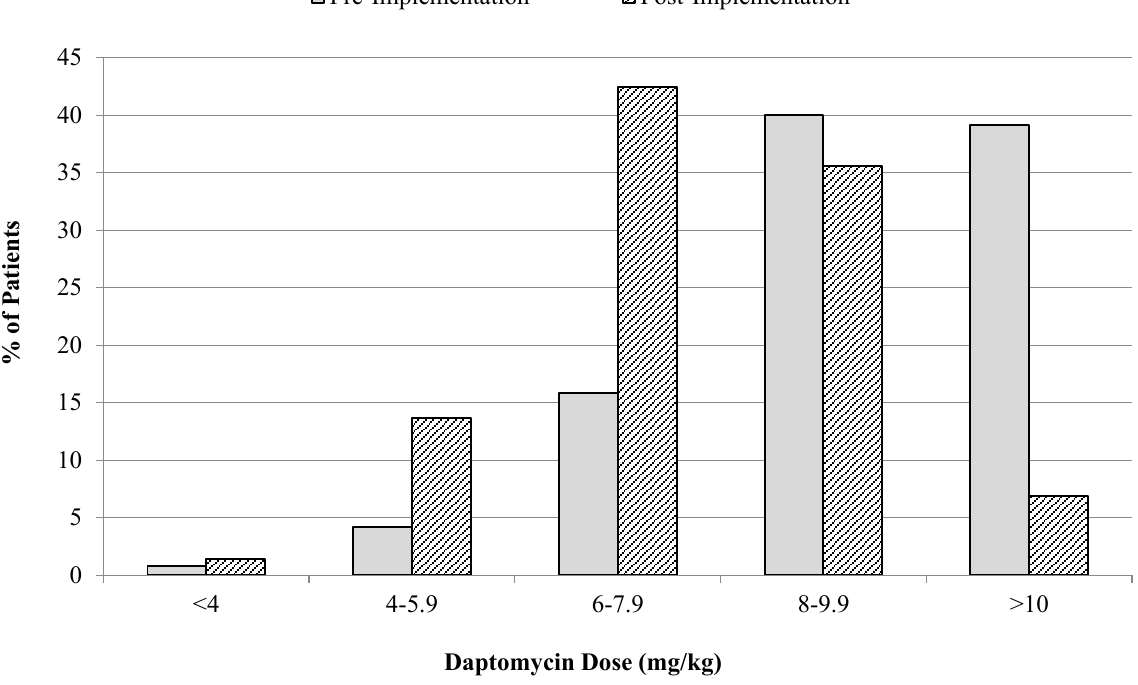
Figure 1. Mean daptomycin dose pre- and post-intervention. Doses are based on the total body weight documented at the time of daptomycin